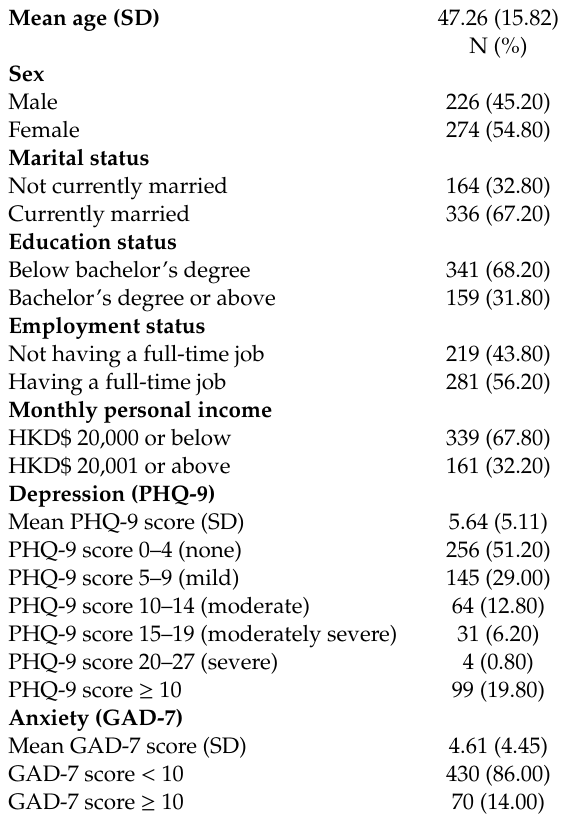
Table 1. Demographics of the